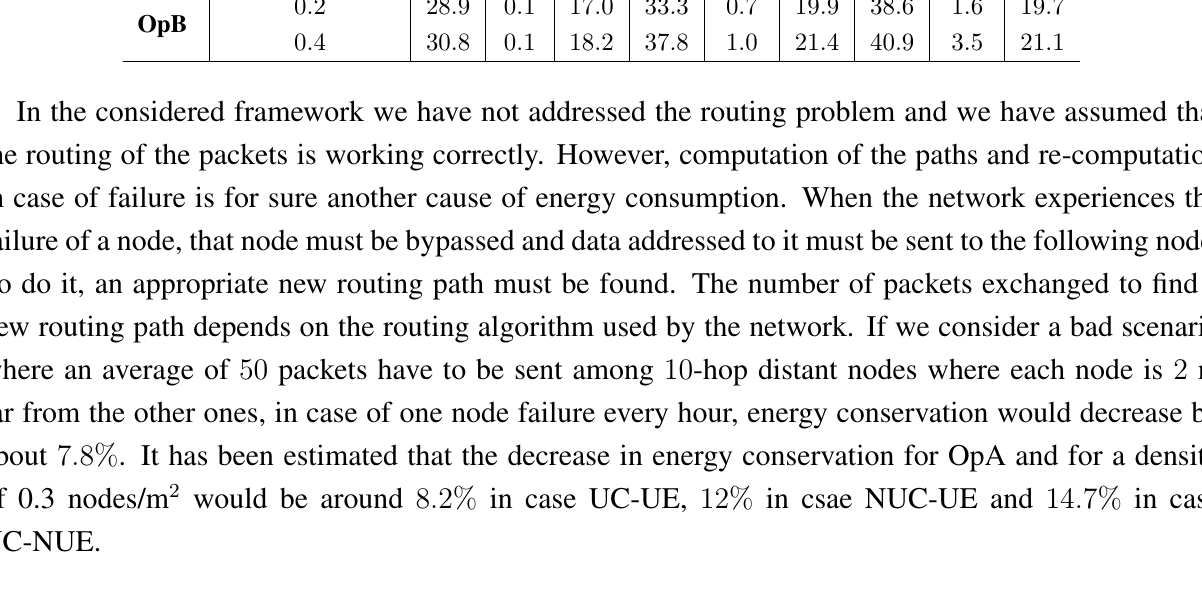
Figure 8. Percentage of energy conservation for every area of the network for OpA, comparison C, in cases UC-UE, NUC-UE and UC-NUE, for a density of 0 : 3 nodes=m 2 , for an increasing distance of the area from the